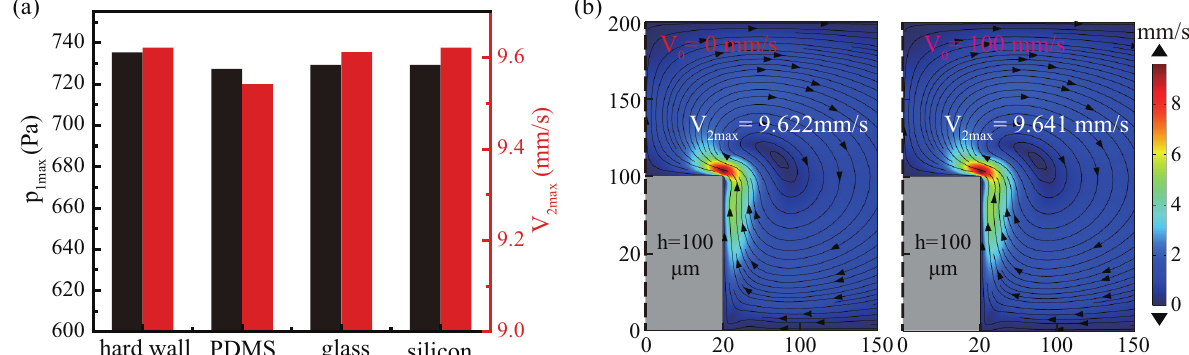
Figure A1. Simplification of Boundary Conditions. ( a ) Comparing the effects of first-order acoustic field wall conditions including hard and impedance wall on p 1 max and V 2 max . ( b ) Comparing the effects of different background flow velocities (0 and 100 mm/s) on streaming. Where h = 100 µ m, H = 200 µ m, f = 10 kHz, η = 0.89 mPa.